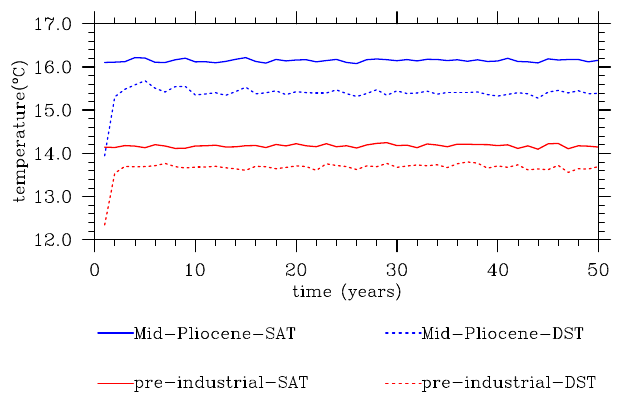
Fig. 1. Time series of global annual mean surface air tempera- ture ( ◦ C) and the deepest soil temperature (DST, ◦ C) in the pre- industrial and mid-Pliocene